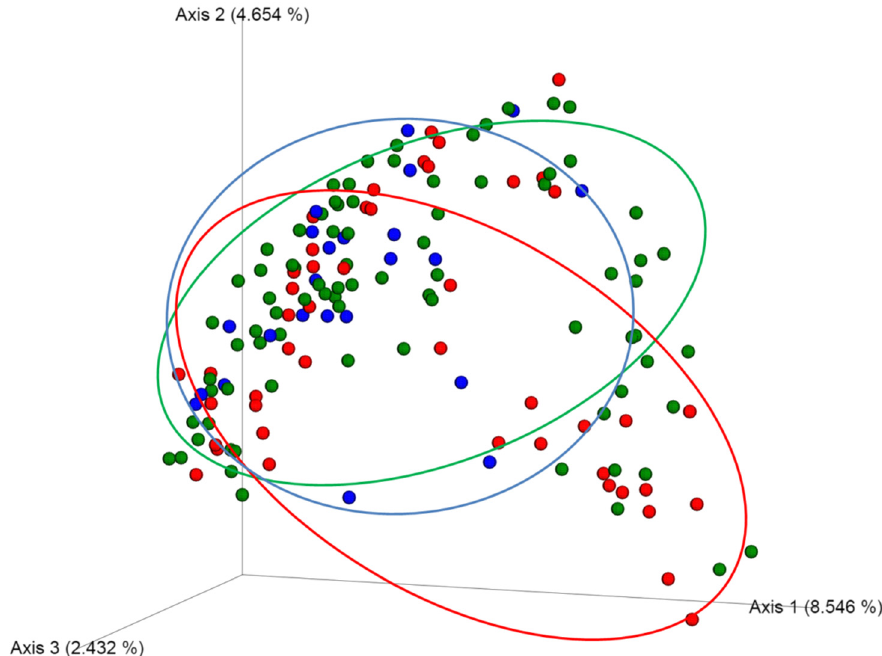
Figure 3. Principal component analysis representation of the skin microbiota at baseline, as a function of the occurrence of PVC colonization. In red and green the samples corresponding to future PVC colonization (above and below the threshold, respectively) are represented. In blue, the samples corresponding to negative culture are represented. PcoA demonstrated that the composition of the skin microbiota at baseline varied according to the colonization status of the PVC at the time of device removal.